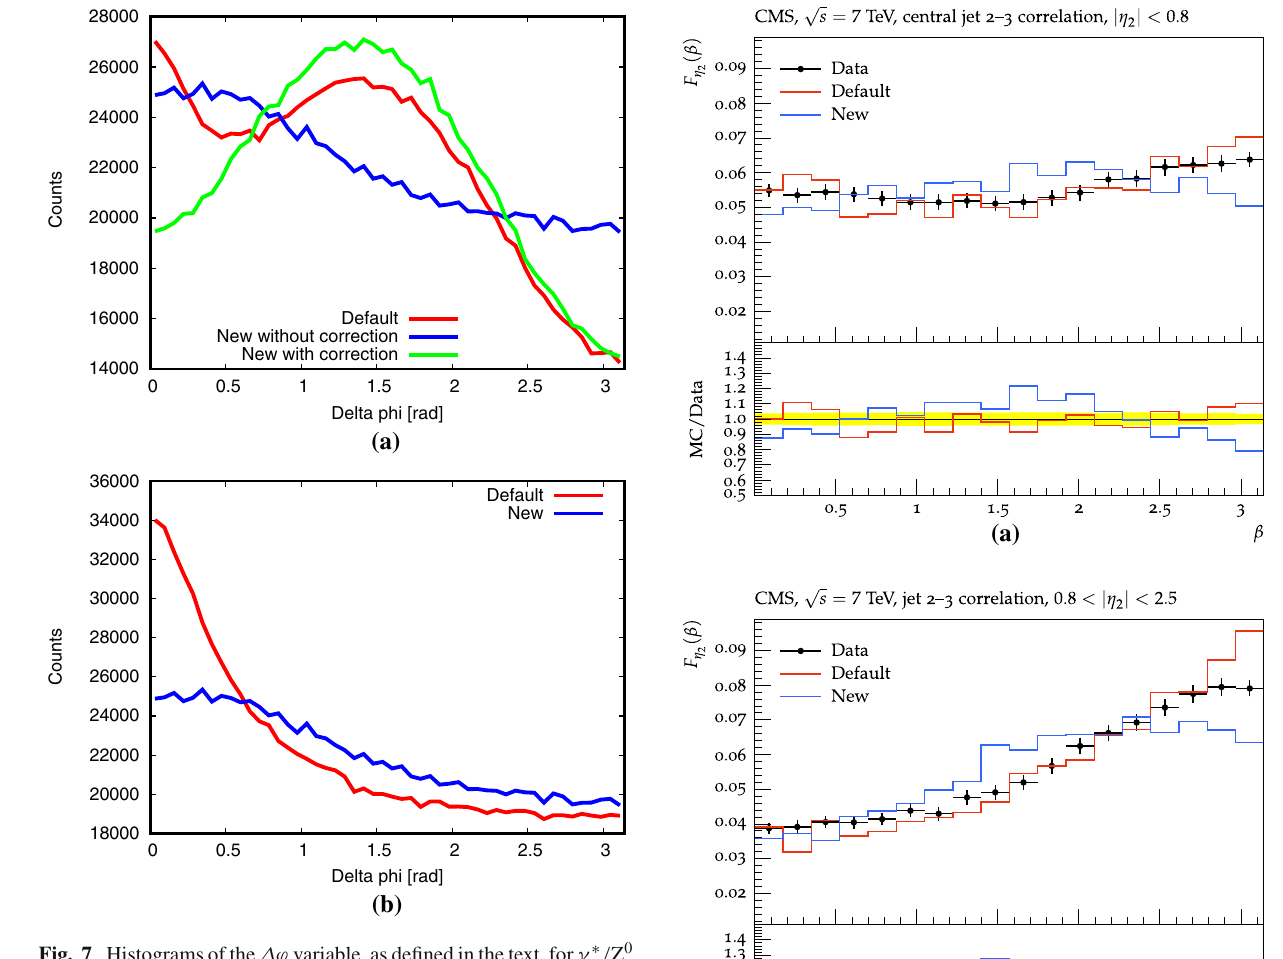
Fig. 7 Histograms of the Δϕ variable, as defined in the text, for γ ∗ / Z 0 production. In a , the red curve is for the old global-recoil scheme whereas blue and green are for the new dipole scheme with or with- out gluon polarization effects included. In b , the gluon polarization effects are removed so only the colour-coherence azimuthal asymme- tries remain. Note the suppressed zero on the vertical axis